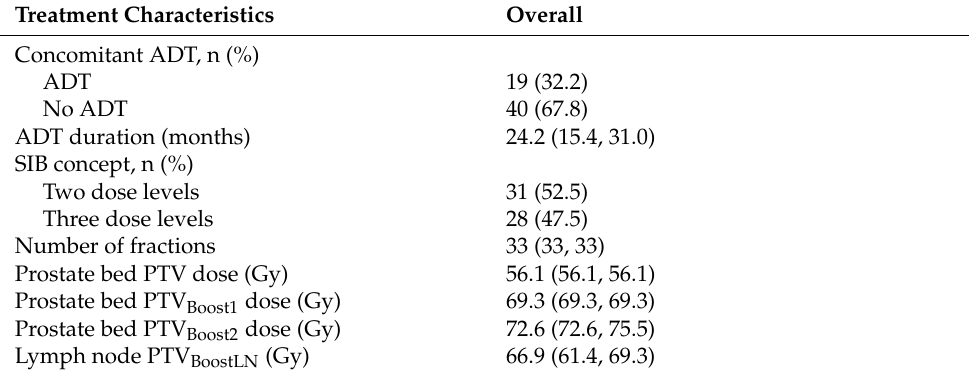
Table 2. Treatment